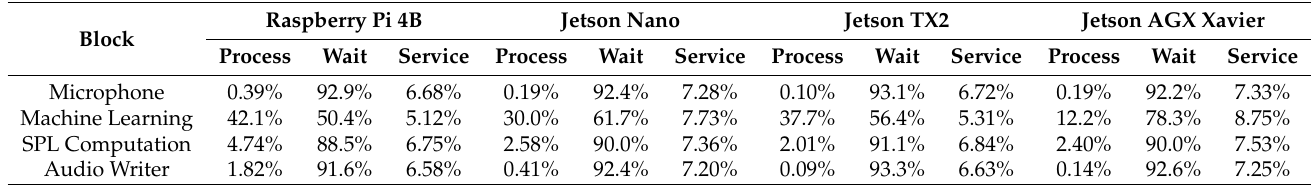
Table 3. Time spent by different blocks in the audio processing pipeline (Figure 4b) performing data processing, idle waiting, and servicing the data between blocks. Comparison is given for different embedded platforms ranging from a low-budget Raspberry-Pi 4B to the high-performance NVIDIA Jetson AGX Xavier. The service times remain well under 10% for each platform, which indicates negligible performance overhead introduced by the REIP SDK. No dropped buffers were